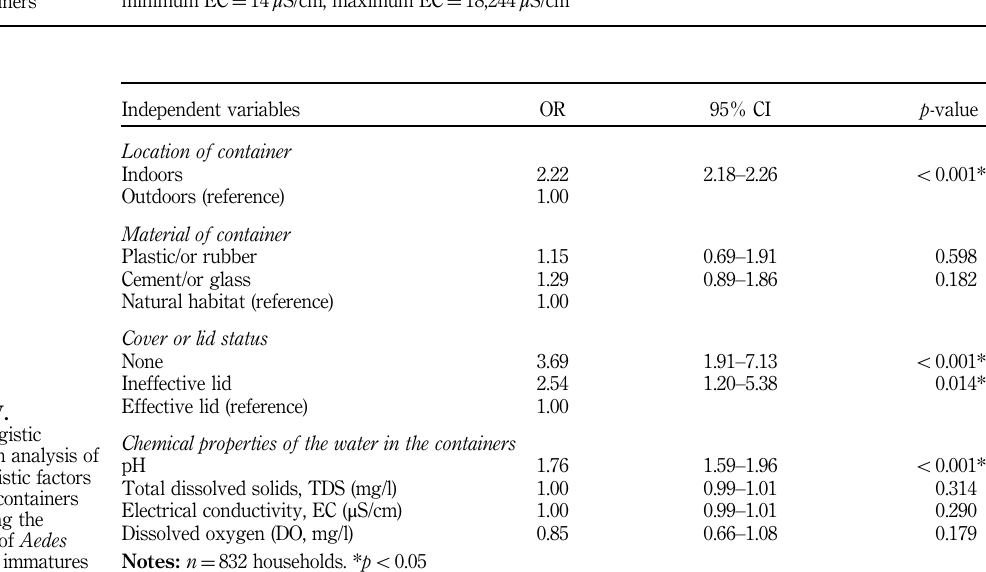
Table III. Chemical properties of the water inside the containers